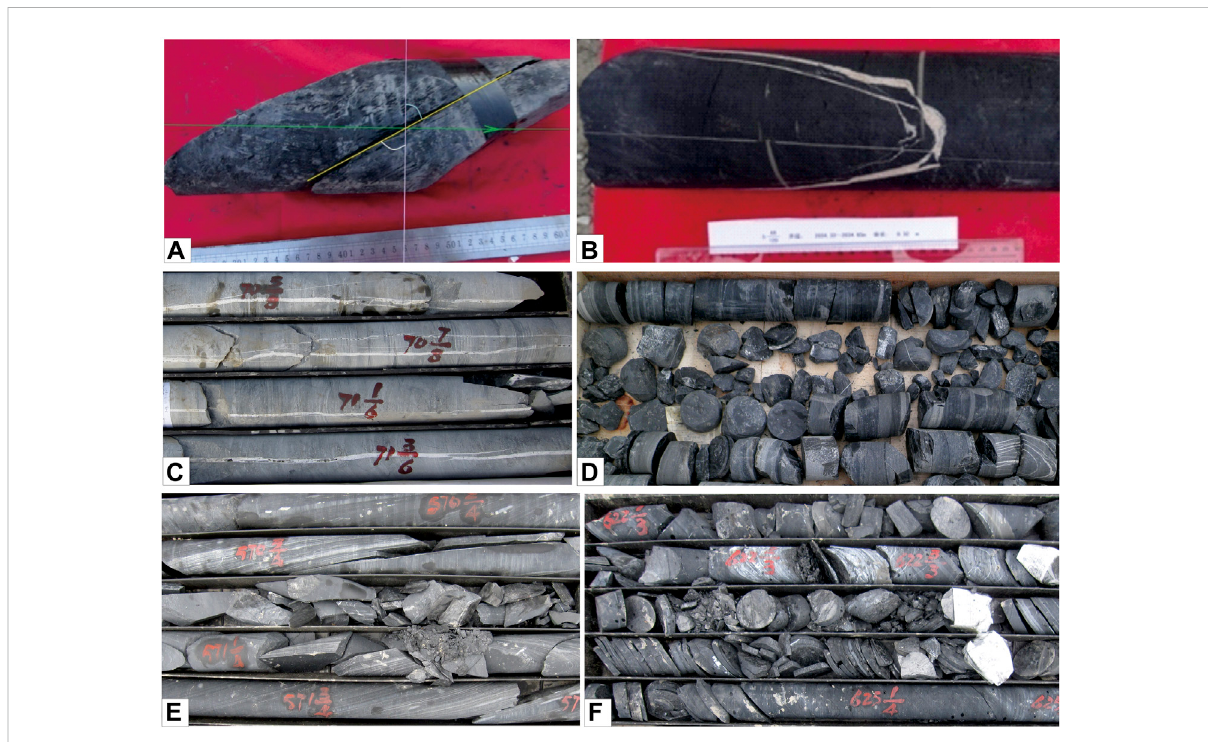
FIGURE 8 Typical drilling core photographs of the Longmaxi Formation. (A) X203 well, 3,553.50 m, with high-angle strata, and the red line direction is the stratum layer; (B) X203 well, 3,586.75 m, with high-angle fractures, and the fracture surface is fi lled with calcite veins; (C) WQ1 well, 258.35 – 261.20 m, with vertical fractures, and the fracture surface is fi lled with calcite veins; (D) WQ1 well, 343.75 – 348.62 m, with seriously broken strata and the core is broken into pieces; (E) WQ2 well, 1,174.50 – 1,177.64 m, with high-angle strata and light sandy lamina; (F) WQ2 well, 1,192.71 – 1,296.85 m, with a seriously crumpled and deformed strata, and the rock core is broken into pieces along the bedding plane.